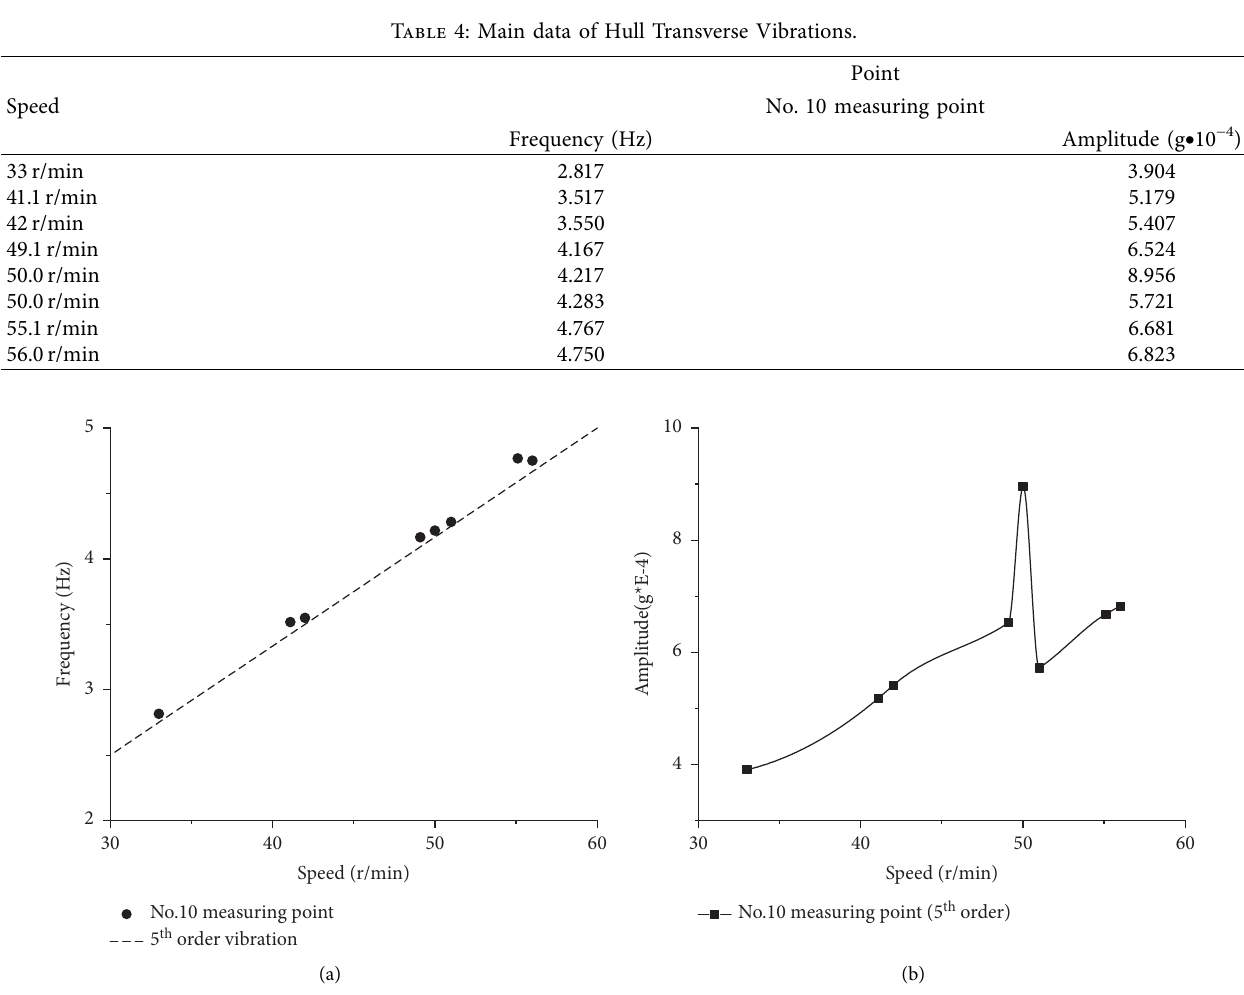
Figure 11: Main parameters of hull transverse vibrations. (a) frequency (b)